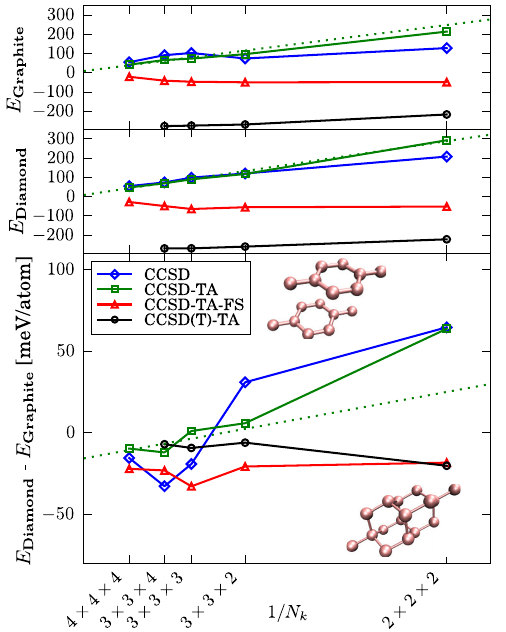
FIG. 3. Energy difference between carbon diamond and graph- ite phases. The dotted line represents the linear fit of the uncorrected values with shifts. (T) corrections (black) are on top of CCSD-TA-FS energy obtained using a 4 × 4 × 4 k -point mesh (red). Zero-point energies are included, and they stabilize graphite compared to diamond by 9 meV =